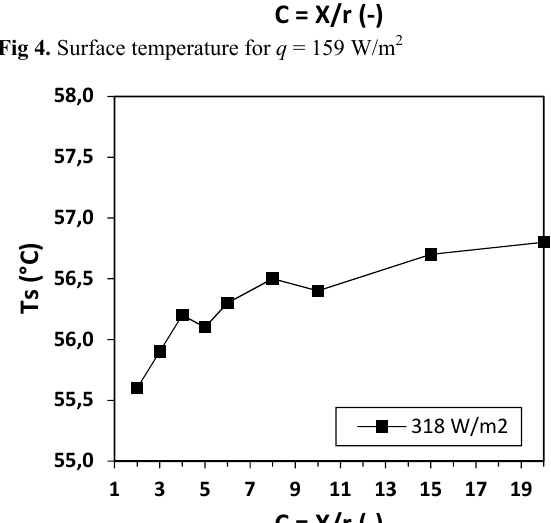
Fig. 5. Surface temperature for q = 318 W/m 2